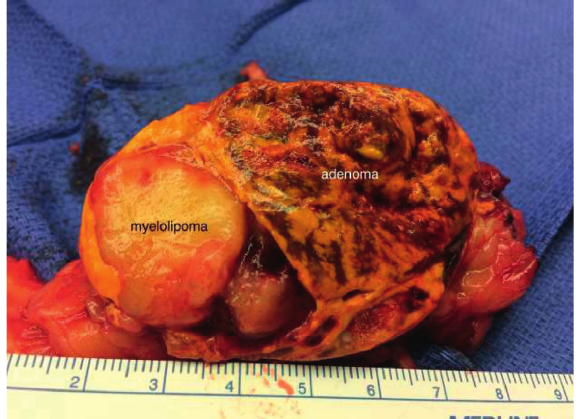
Figure 2: The surgical specimen demonstrates the characteristic macroscopic fat component of the myelolipoma with an adjacent well- circumscribed solid golden yellow adenoma.